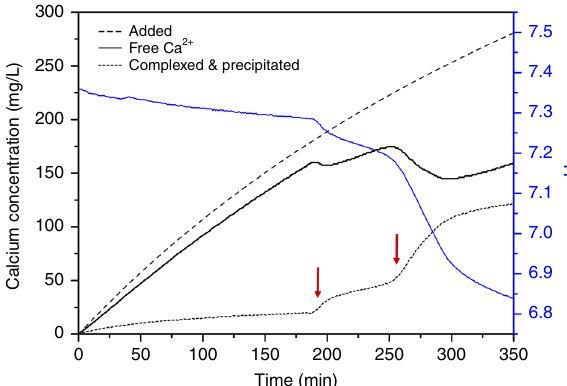
Fig. 1 Free calcium pro fi le of the titration system without external surfaces. The black line gives the free calcium concentration measured by a calcium ISE. The added amount of calcium ions is given by the dash line. The difference of the two indicates complexed and precipitated calcium, shown by the dotted line. Two red arrows indicate the onset point of two distinct events that resulted in the rapid consumption of free Ca 2 + ions. The pH is given by the blue